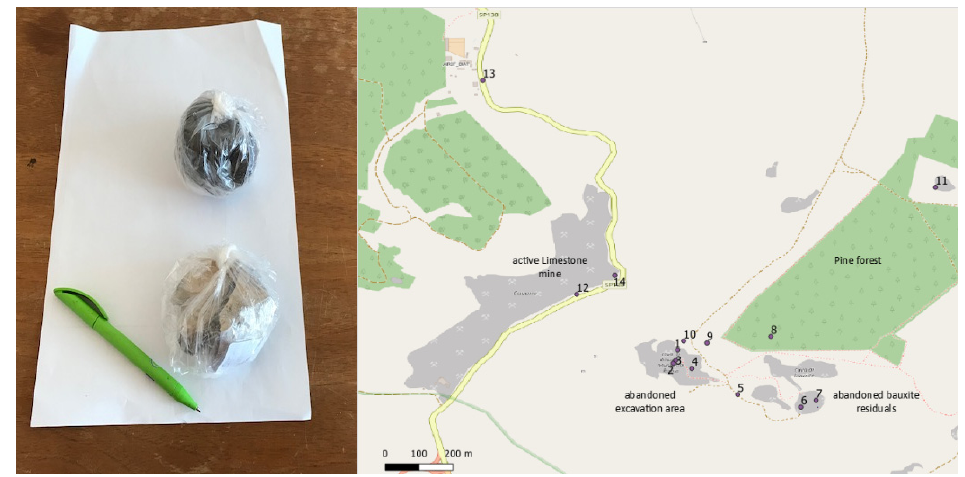
Figure 4. In situ samples ( left ) taken from different case study areas (numbers in the map, right ).